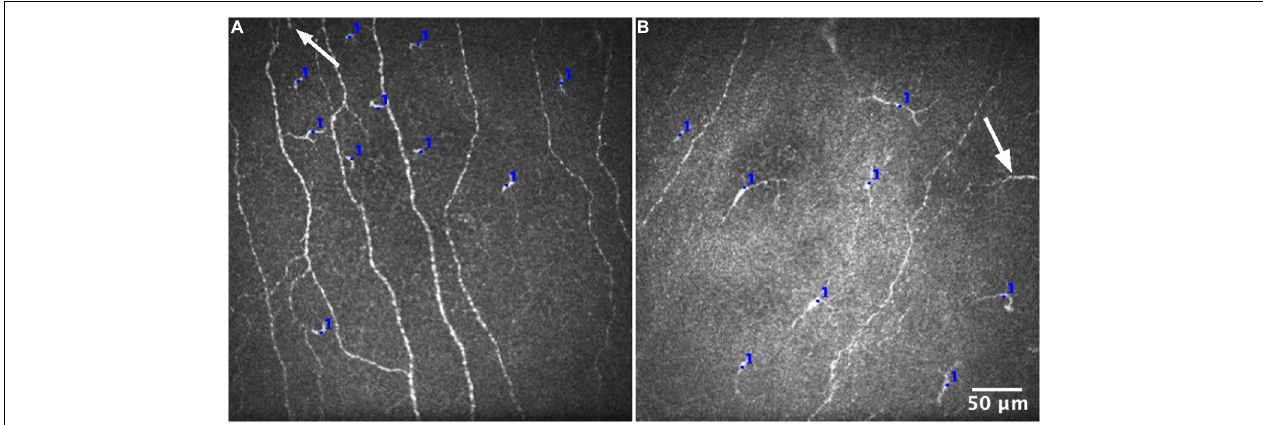
FIGURE 1 | Representative IVCM images for quantifying epithelial immune cell density from the central (A) and peripheral (B) corneal regions. The number of cells was manually counted in each IVCM image, using the Cell Counter plugin in ImageJ (blue marks). Cells that were only partially visible at the edge of an image (white arrows) were consistently excluded from the analysis.